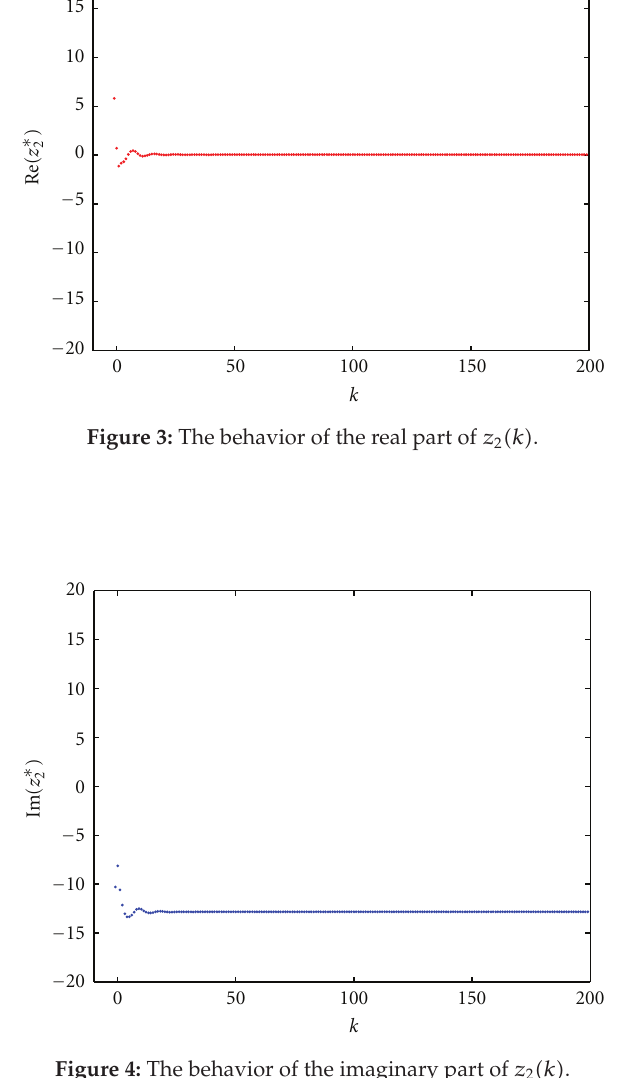
Figure 4: The behavior of the imaginary part of z 2 (cid:5) k (cid:7)